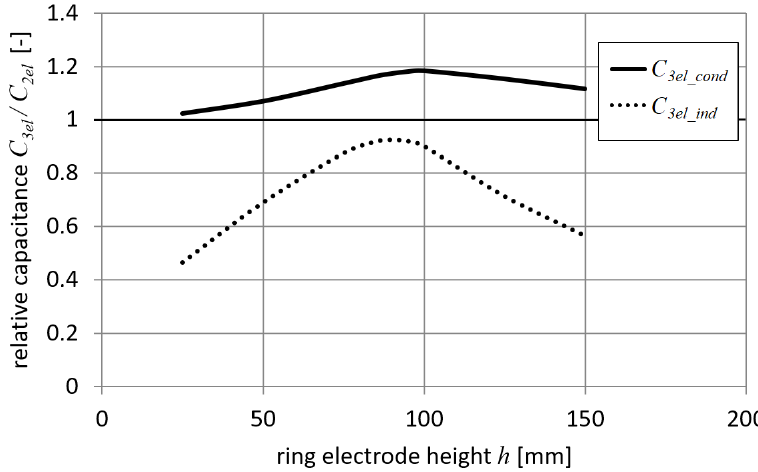
Figure 9. Droplet capacitance C 3 el values for induction and conductive charging methods, relative to the capacitance of the 2-electrode system C 2 el , as a function of ring electrode height h . Simulation parameters: r d = 80 mm, t d = 200 mm (i.e., a wide ring electrode and a big target).